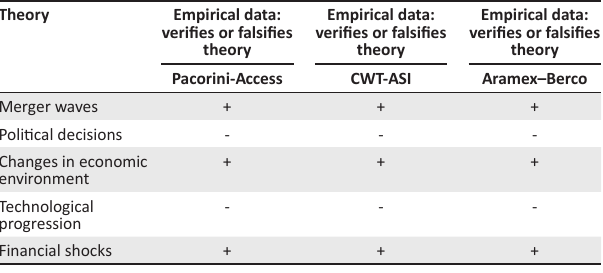
TABLE 4: Macro-economic factors determining acquisition